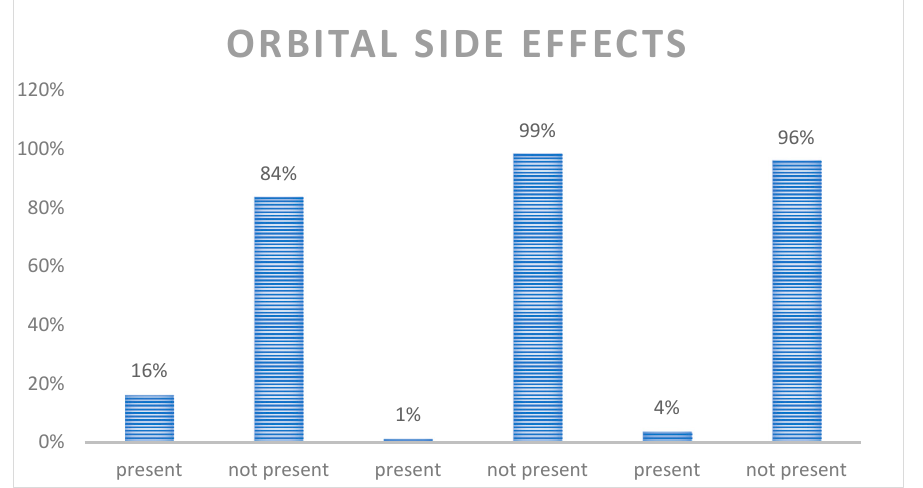
Figure 2. Type of fracture.